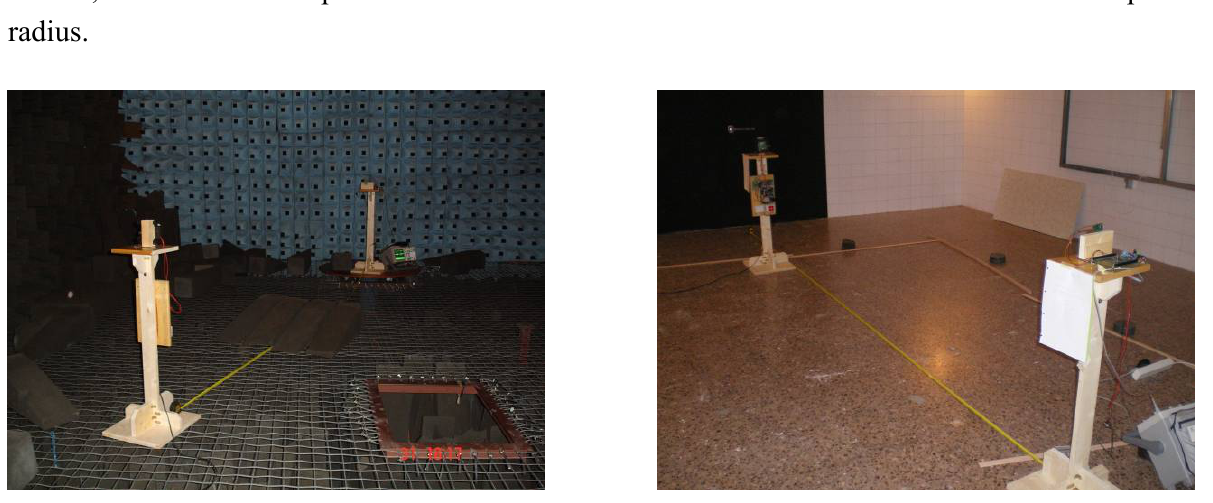
Figure 26 . Anechoic and reverberant chamber